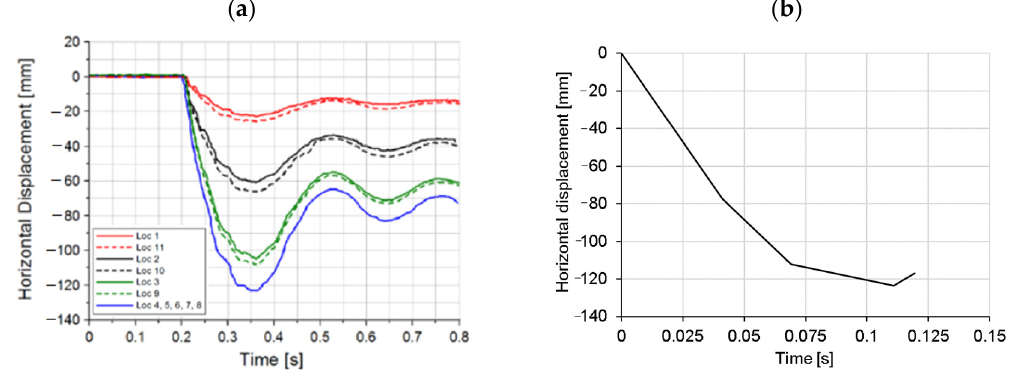
Figure 7. ( a ) In the experiment measured displacement load history (Parmar et al., 2014) and ( b ) displacement load history applied in the finite analysis at the mid line of the pendulum (see Figure 5c).